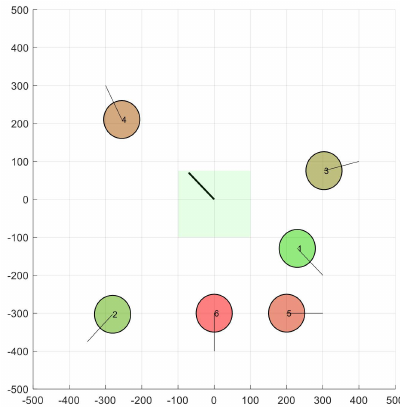
Figure 6. Valid velocity space truncated (node 1 against node 3).